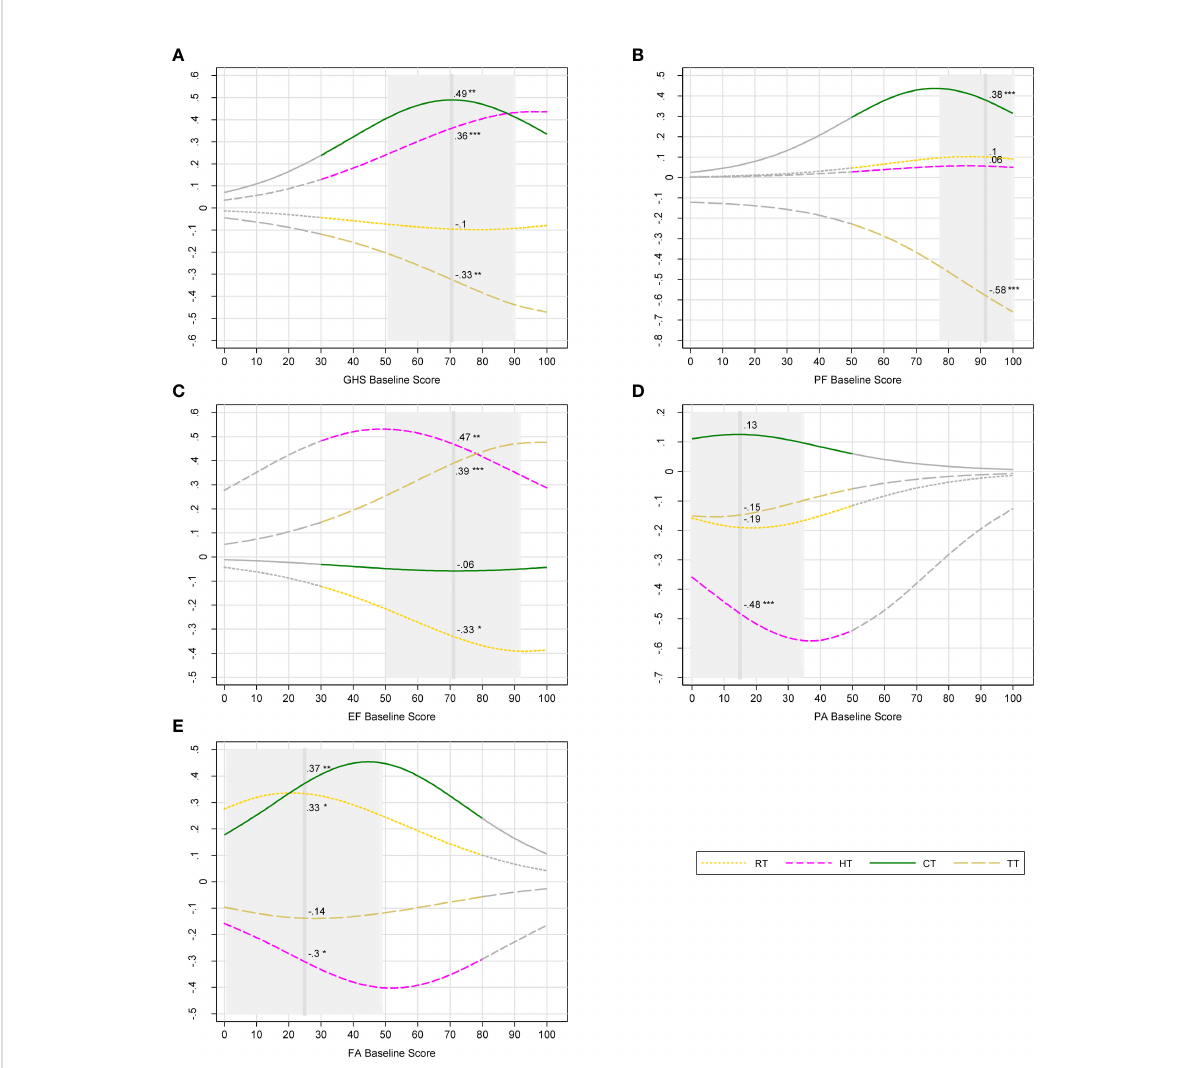
FIGURE 3 Incremental probability of post-operative outcomes of breast cancer therapies. (A) Global health status deteriorations; (B) physical functioning deteriorations; (C) emotional functioning improvements; (D) pain deteriorations; (E) fatigue deteriorations. Notes: Breast cancer therapies: RT, radiotherapy; HT, hormone therapy; CT, chemotherapy; TT, targeted therapy. Post-operative outcomes were measured with European Organization for the Research and Treatment of Cancer Quality of Life Questionnaire (EORTC QLQ-C30). QLQ-C30 domains: GHS, global health status; PF, physical functioning; EF, emotional functioning; PA, pain; FA, fatigue. Higher scores represent better health-related quality of life (HRQoL) for GHS, PF, and EF. In the contrary, higher scores represent more severe problems and lower HRQoL for PA and FA. Deteriorations and improvements where de fi ned with minimal important difference (MID) of change score (post-operative score minus baseline score). Gray part of curves: zones in which the number of participants is less than 5; vertical dash line: mean baseline score; Gray area ± 1 SD from mean baseline score, truncated if it crosses the minimum score (0) or the maximum score (100). Incremental probabilities were derived from ordinal logistic regression. The incremental probability indicates the differential probability of deteriorations/improvements in PROs brought by one therapy. For each baseline score, the incremental probability is equal to the probability of deteriorations/improvements with one therapy minus the probability without the therapy. Numbers beside the curves indicate the incremental probability at mean baseline scores. Signi fi cance level: null hypothesis = the incremental probability is equal to zero at mean baseline score; *p-value< 0.05, **< 0.01, and ***< 0.001. Example: Receiving CT increases signi fi cantly the probability of GHS deteriorations by 49% given that a patient had a baseline GHS score of